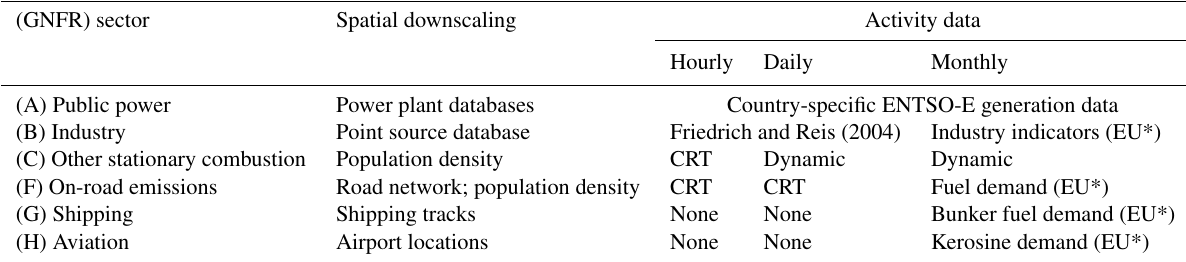
Table 2. Anthropogenic combustion sectors and their spatial and temporal downscaling proxies. “Dynamic” indicates a dependence on meteorology, whereas the CRT (CAMS-Regional Time profile) denotes static activity data taken from Guevara et al. (2021). “None” means a flat profile (i.e., no scaling based on activity) for that time period: if a sector has a flat monthly profile, every month is assumed to have the same emissions. EU*: Eurostat data. Note that we only include surface emissions.